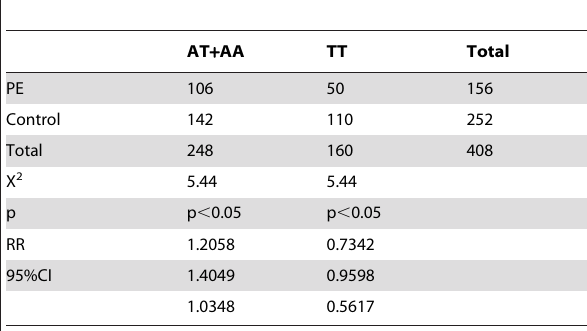
Table 4. RR and 95%CI of Foxp3 -6054 AT + AA mergergenotype in PE and control